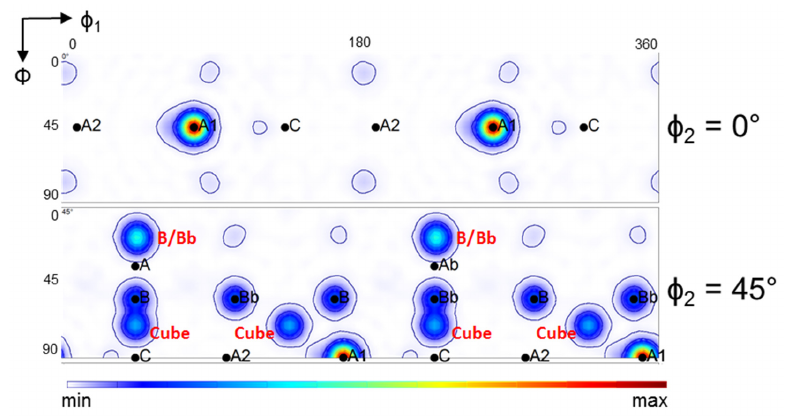
Figure 12. The twin positions and their relative strength formed by the ideal texture components in ECAP, taking all ideal texture components with the same intensity. Ideal orientations twinning into each other are indicated with black letters: the A1 is originating from A2, the B is from Bb, inversely, the Bb from B. The Cube ‐ originated twins are indicated by red letters, also two twin components of B/Bb that are not in ideal positions for simple shear.